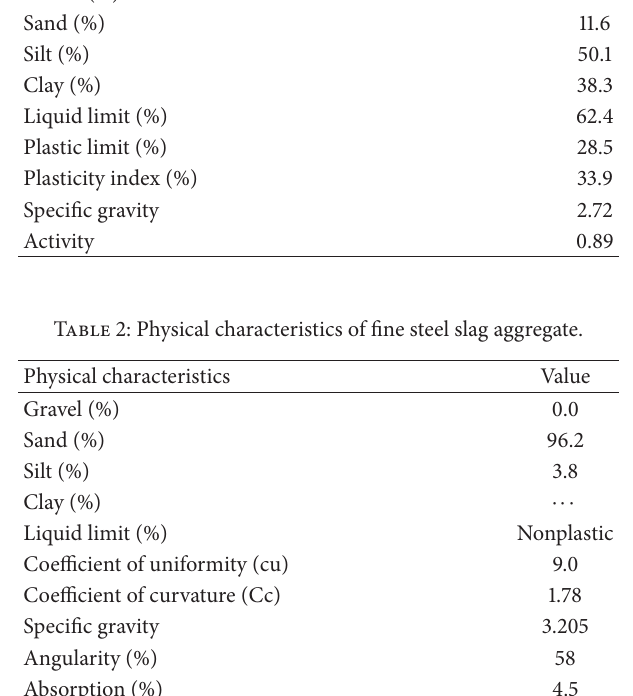
Figure 2: Grain size distribution of the fine steel slag.